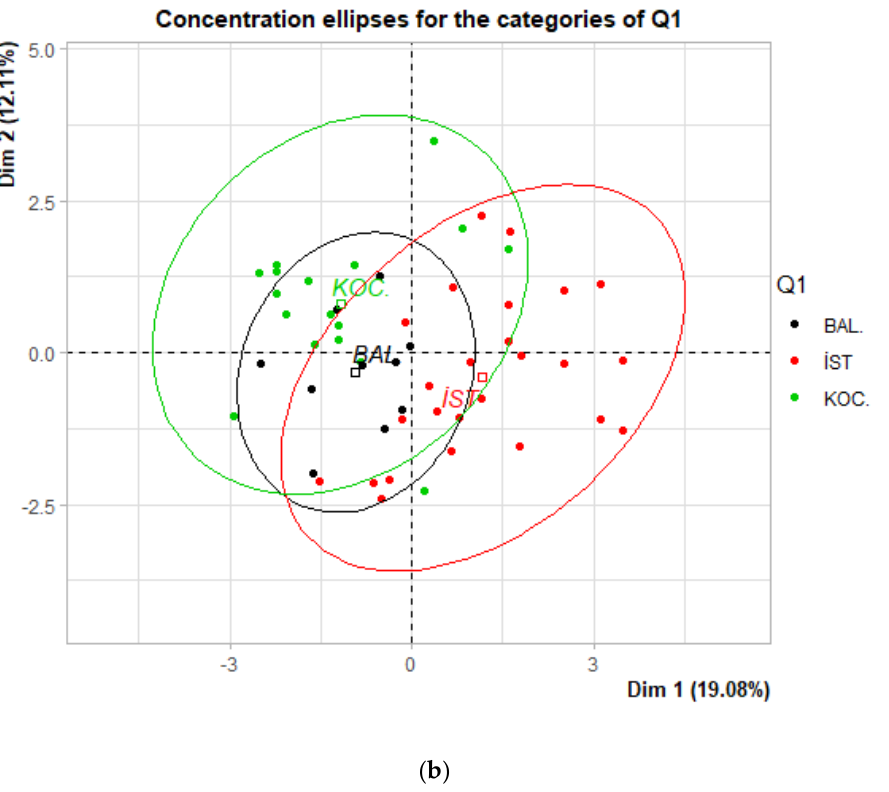
Figure 1. ( a ) The location of each cluster was revealed according to the hierarchical cluster analysis (class.hcpc). Dots represent the coordinates of each farm, squares represent the geometric centre of each cluster, circles indicate the 95% confidence interval, dim 1 and 2 are the first two dimensions obtained from the multiple factor analysis (MFA), and in brackets are reported the explained variances from each dim. ( b ) The location of each cluster was revealed from the region (Q1) where Koc. refers to Kocaeli, Bal. refers to Balikesir, Ist. refers to Istanbul, dots represent the coordinates of each farm, squares represent the geometric centre of each cluster, circles indicate the 95% confidence interval, dim 1 and 2 are the first two dimensions obtained from the multiple factor analysis (MFA), and in brackets are reported the explained variances from each dim.